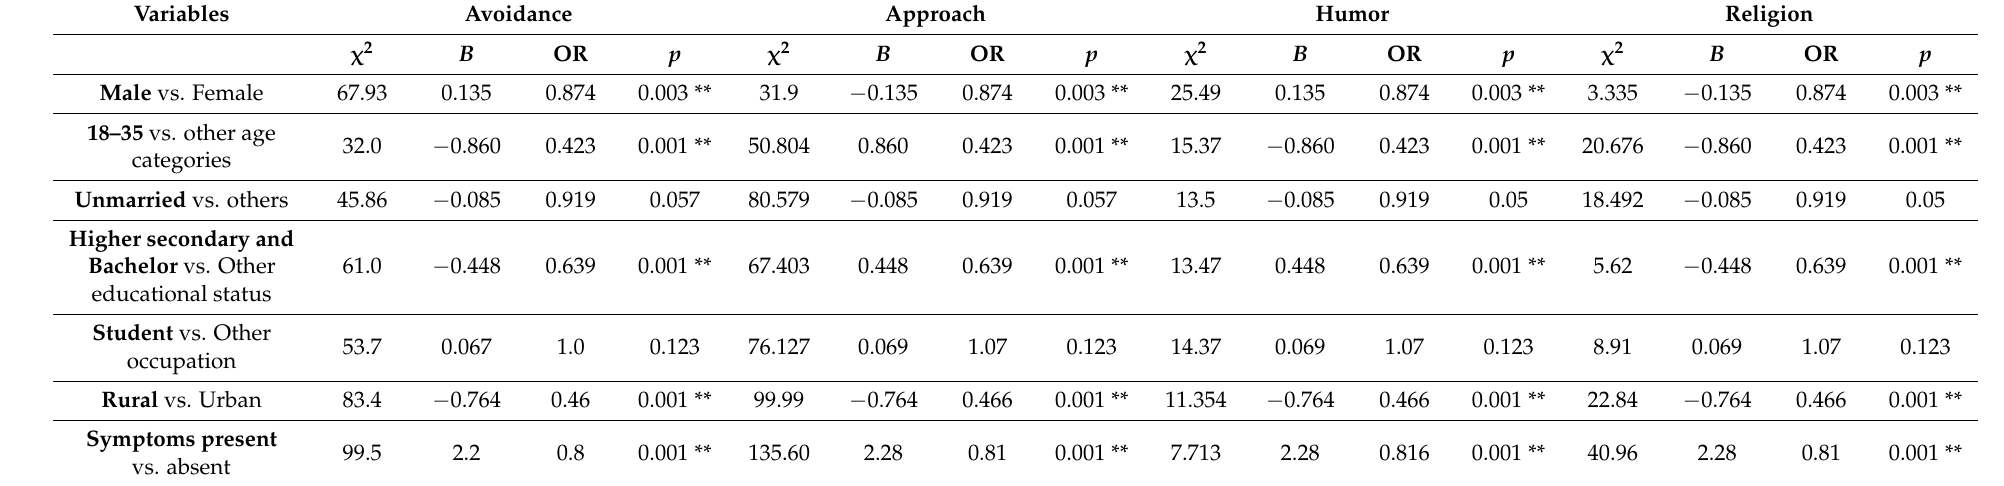
Table 4. Binary logistic regression of socio-demographics and coping